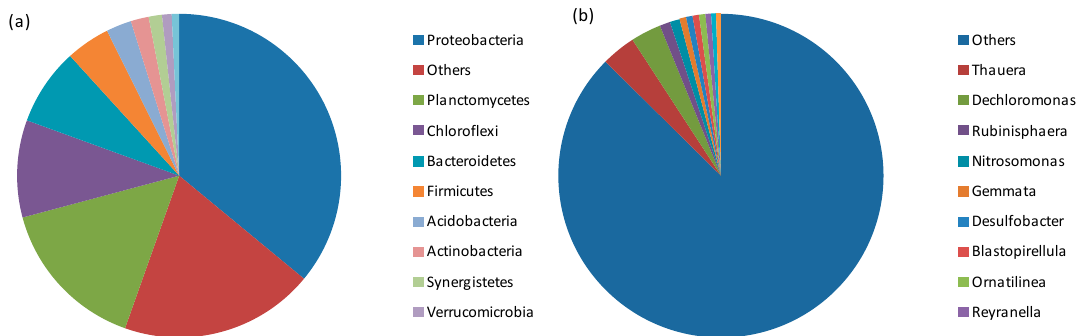
Figure 4. Microbial community structures in the hydrolysis reactor at phylum level ( a ) and genus level ( b ).